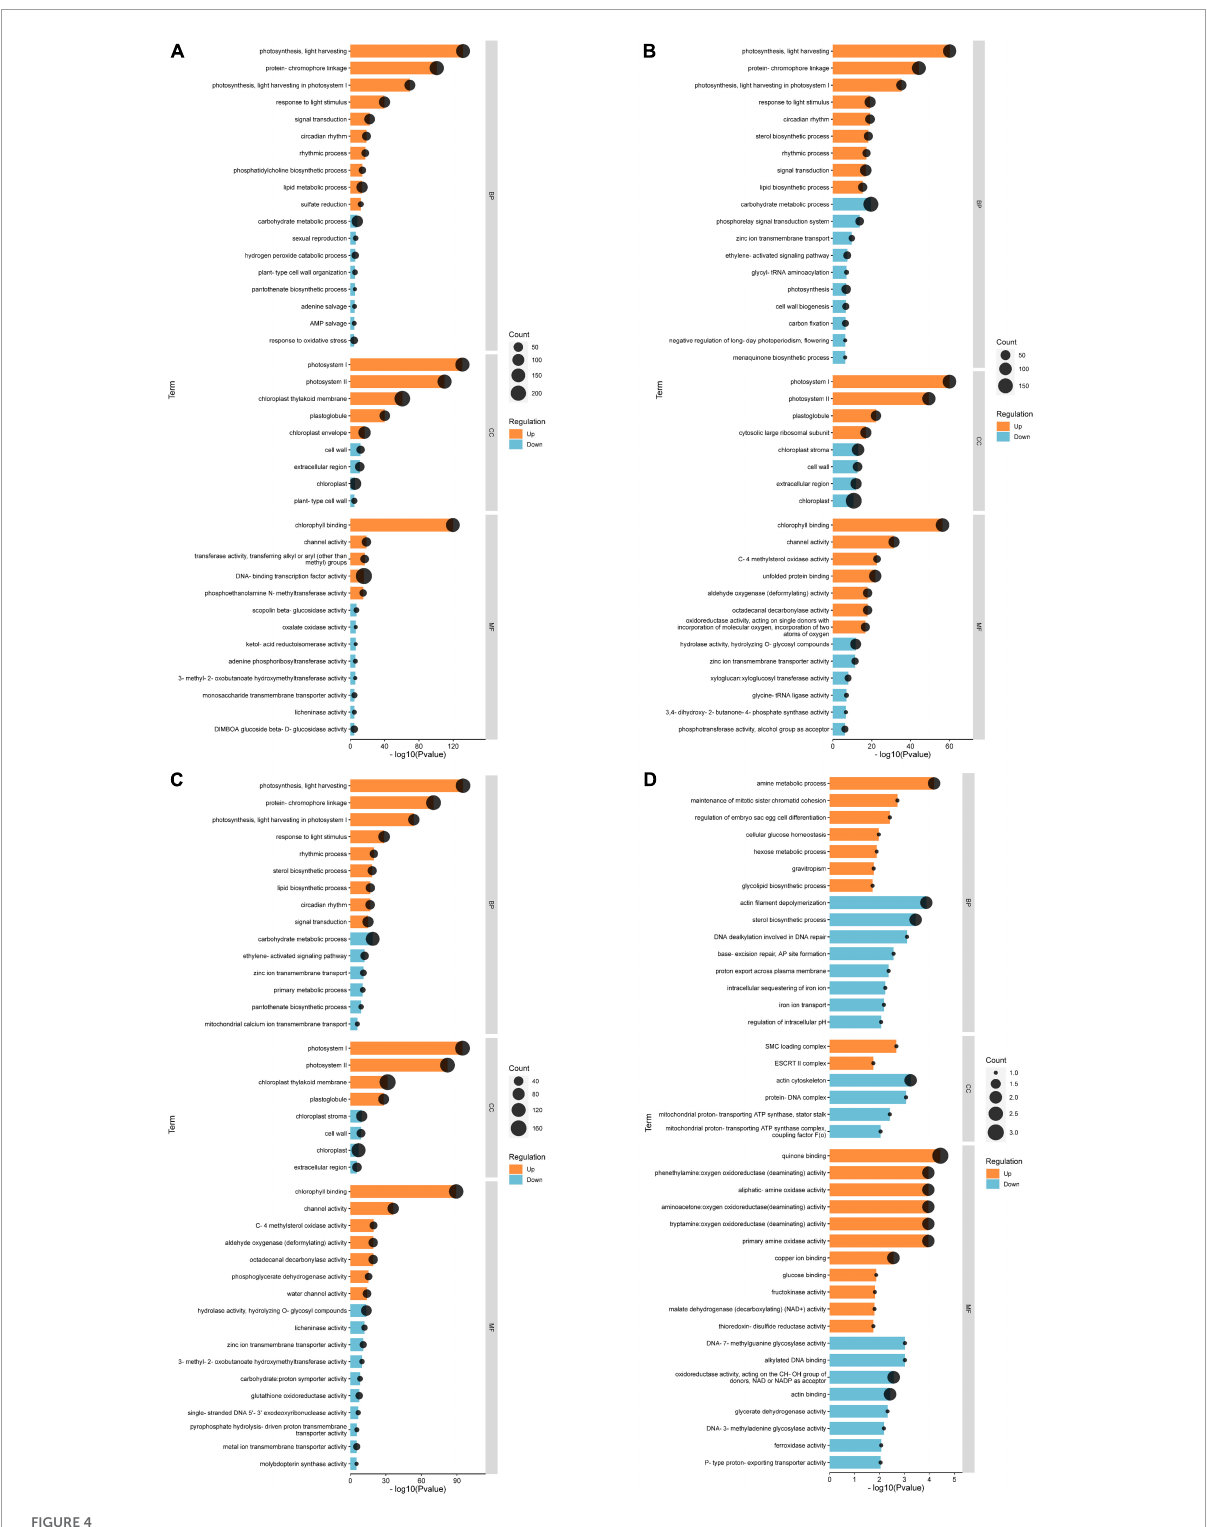
FIGURE4 Gene ontology (GO) classification of genes with significant differences between groups. (A) GO classification of differential genes between CK and EBL; (B) GO classification of differential genes between CK and SALT; (C) GO classification of differential genes between CK and SE; (D) GO classification of differential genes between SALT and SE. The top 20 up-regulated genes between two groups were shown in orange and the top 20 down-regulated genes were shown in